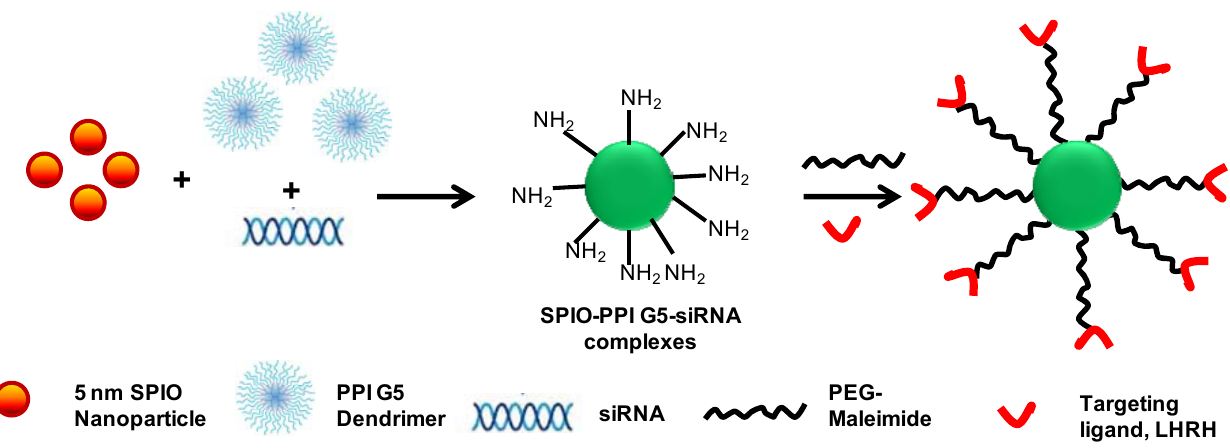
Figure 5. Lipid modification of G(4)-PAMAM dendrimers for enhanced siRNA delivery and siRNA-drug co-delivery. Green fluorescence of FAM-labeled siRNA and